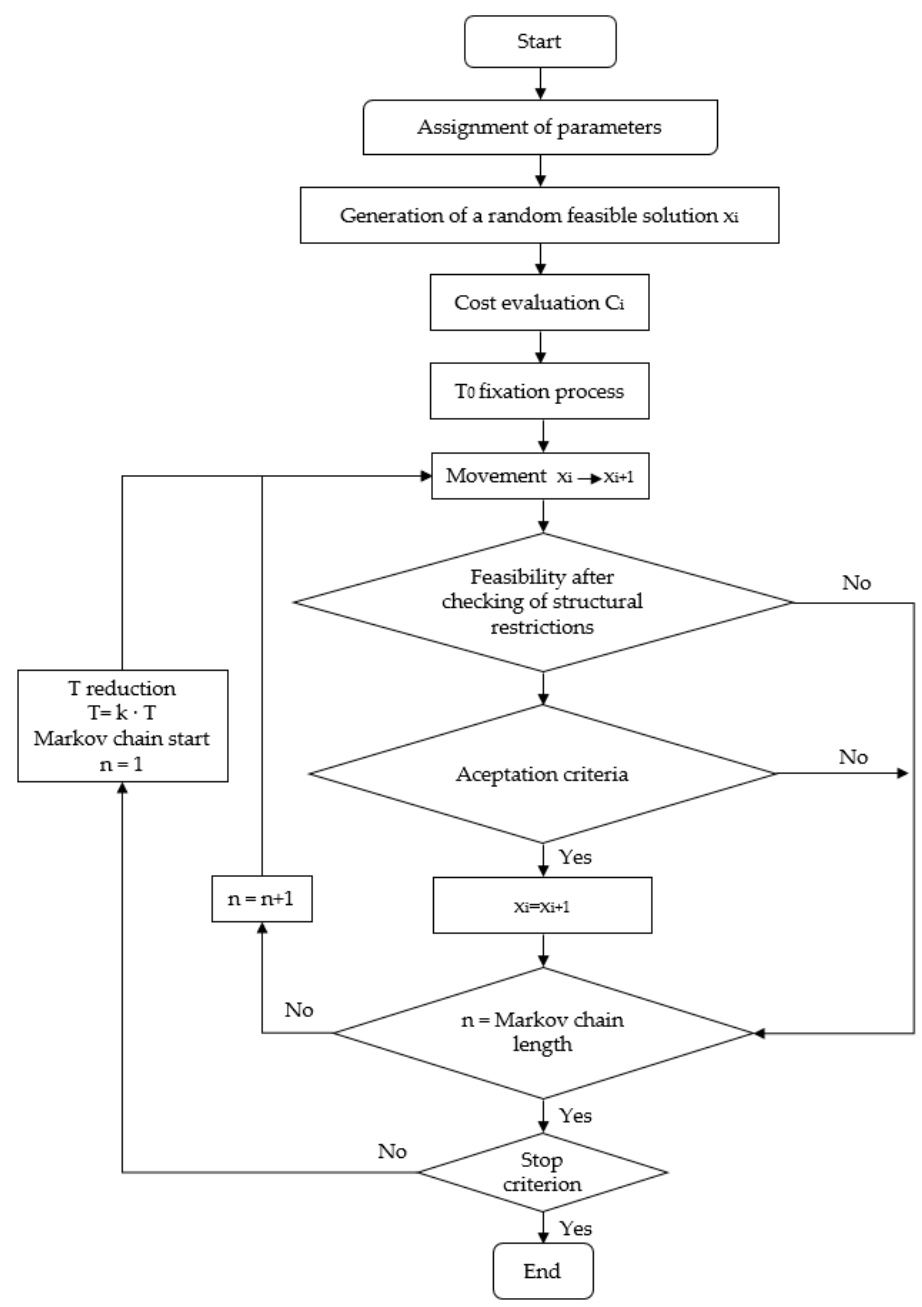
Figure 4. Flowchart of the hybrid simulated annealing with a mutation operator (SAMO2) process.